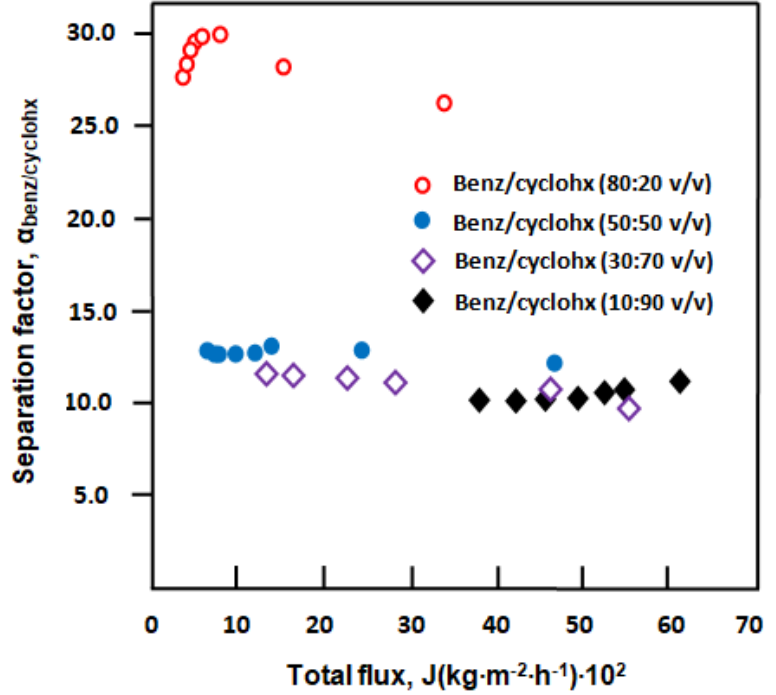
Figure 11. Change in the separation factor for benzene/cyclohexane mixture with different compositions versus total flux rate in the E-VOH –membrane.